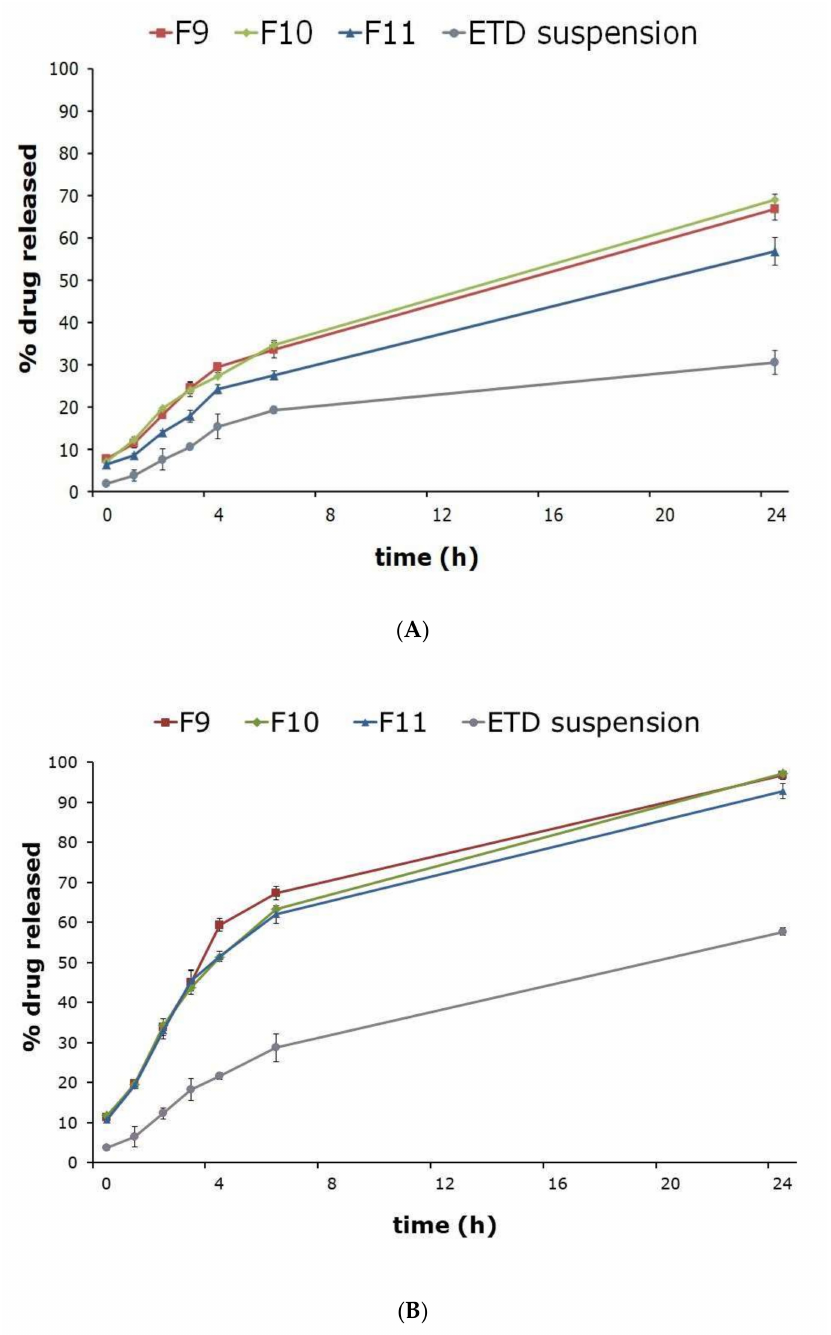
Figure 3. The ETD release from NLC formulations in: ( A ) acetate buffer (pH 5.5), ( B ) phosphate buffer (pH 7.4); containing 1% Tween 80 (mean ± SD; n =